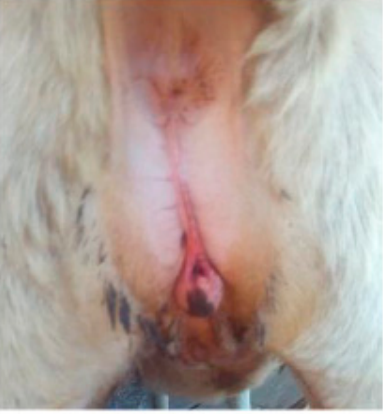
Figure 3. Case 3. Abnormal ano-vulva distance and enlarged clitoris.